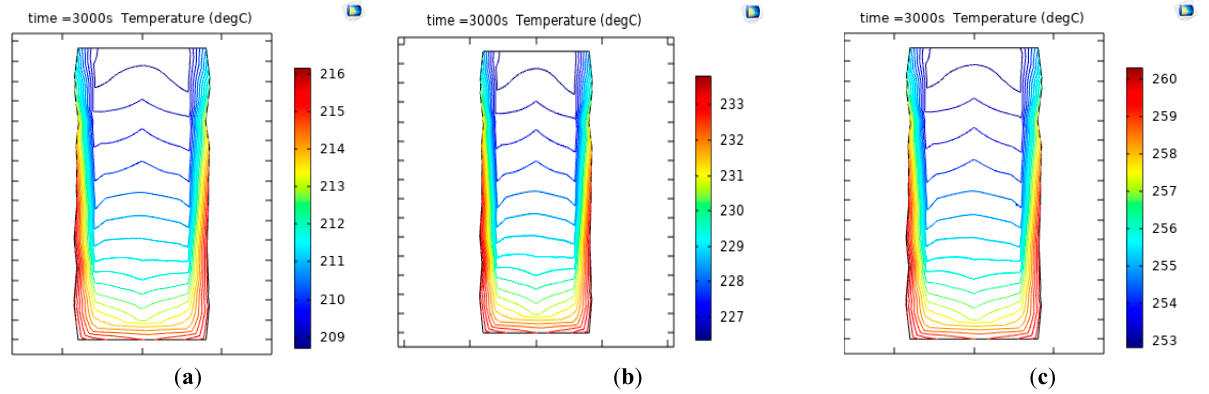
Figure 10. Isotherms inside the reactor at 3000 s after the onset of the HTC process: Effect of the imposed wall heat flux, ( a ) q 0 = 2.0 kW; ( b ) q 0 = 2.3 kW; ( c ) q 0 = 3.0 kW.